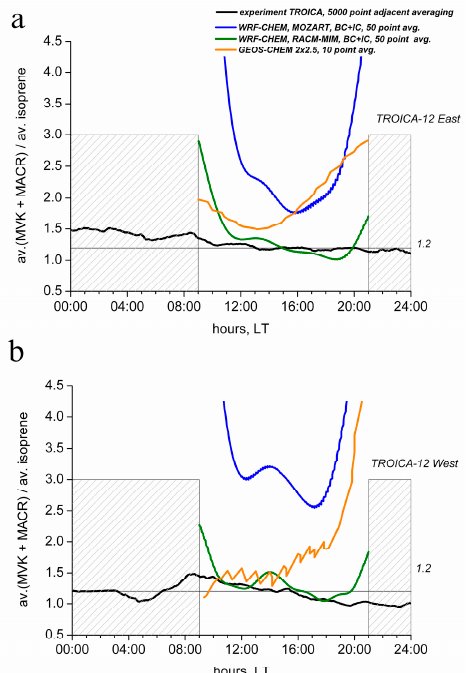
Figure 6. Average diurnal variations of the ratio of experimental TROICA-12 East ( a ) and West ( b ) data and for model simulations. The shaded area shows the nocturnal values. The oscillations of 10 points, adjacent to the average GEOS-CHEM curve, is the result of averaging over a coarse spatial grid of 2 × 2.5 ◦ . Coincidence between the theoretical and experimental values (black line) is observed only for the WRF-CHEM RACM-MIM model (green line) in the range of 11–19 o’clock of LT. Unrealistic nocturnal model values have been cut off and are not represented in the Figure.